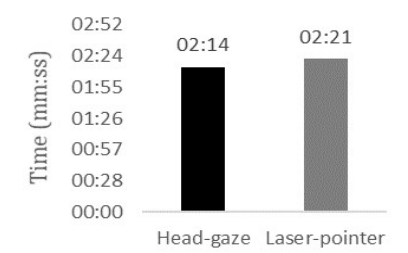
Figure 7. Average task duration in Session 2. Overall participants use slightly less time with the gaze cursor than with the virtual pointer (descriptive statistics only, n=6).